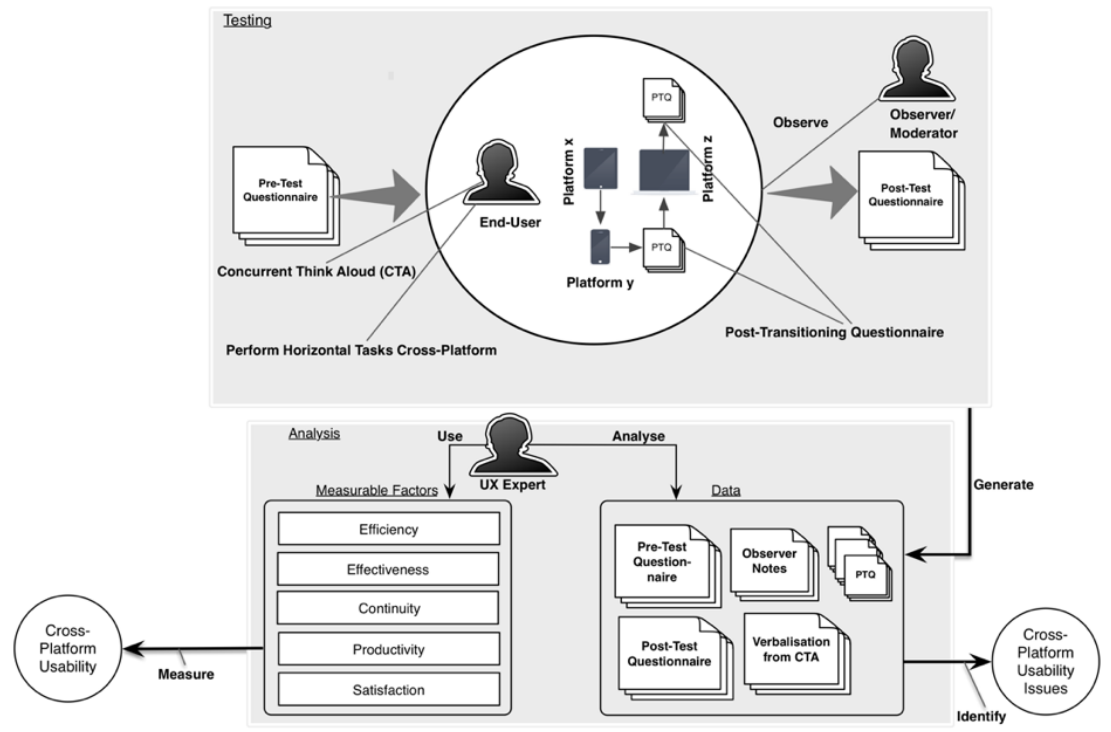
Figure 1. The proposed cross-platform usability assessment model for three user